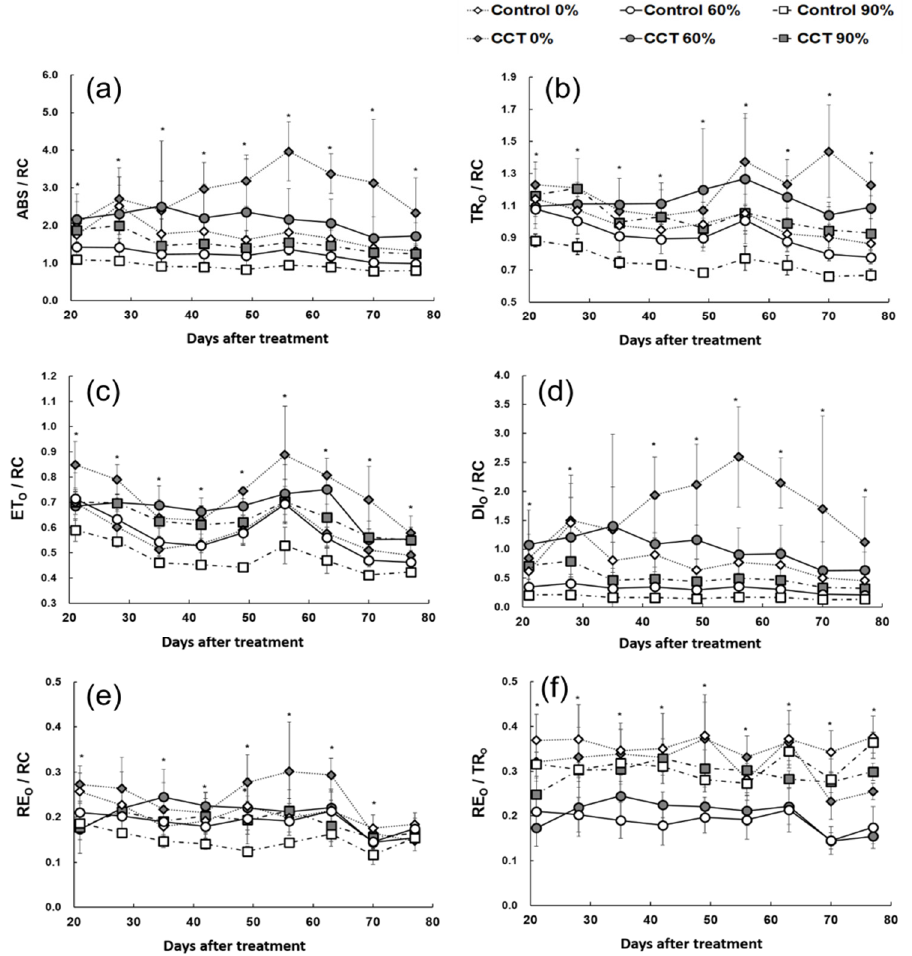
Figure 4. Effects of shading level on several chlorophyll fluorescence parameters (ABS/RC ( a ), TR 0 /RC ( b ), ET 0 /RC ( c ), DI 0 /RC ( d ), RE 0 /RC ( e ), and RE 0 /TR 0 ( f )) of Sedirea japonica under control (CO 2 = 400 ppm) and CCT (climate change treatment, CO 2 = 650 ppm, temperature = control + 3 °C) conditions. Each value is expressed as the mean ± SD ( n = 5). The asterisk indicates significance at p < 0.05.